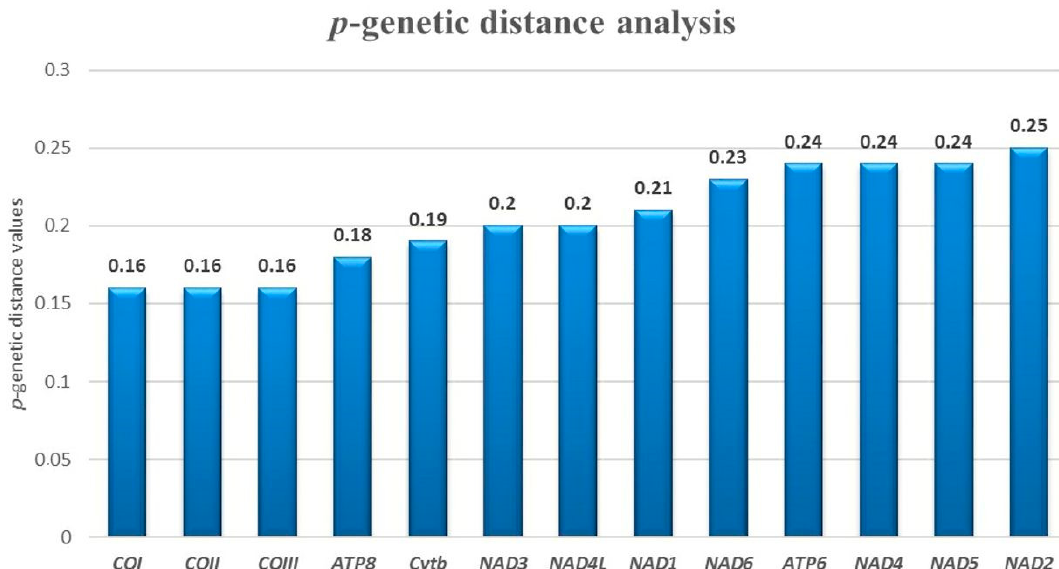
Figure 4. p -genetic distance analysis. The genes were sorted by increasing p -distance values. The gene with the lowest value is COI , while the gene with the highest value is NAD2 .